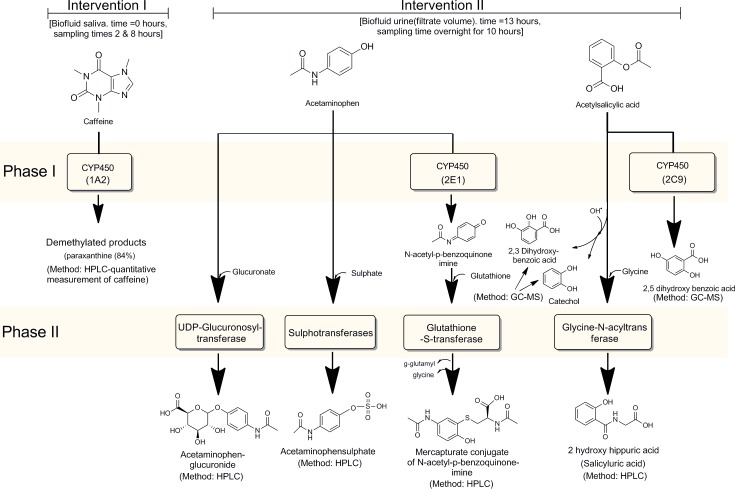
Measurement design for the interventions to assess the biotransformation profiles for all fatigue patients.Caffeine clearance (Intervention 1) progresses through CYP450-1A2, comprises only a phase 1 process and is measured as the residual substrate in saliva, expressed as a percentage of caffeine recovery. The acetaminophen challenge involves three phase II conjugation reactions, evaluated through the products formed following biotransformation: (1) conjugation of glucuronic acid to the hydroxyl group of acetaminophen; (2) sulphation of the phenolic hydroxyl group of acetaminophen; and (3) glutathione conjugation of N-acetyl-p-benzoquinone imine, a phase 1 activated form of acetaminophen. In the simultaneous acetylsalicylic acid challenge, glycination of the functional carboxylic group is catalysed by glycine-N-acyl transferase (GLYAT). All the substances mentioned are measured in urine samples, analysed by HPLC, as indicated. The acetaminophen and salicylate ingestion detoxification are measured through the glucuronide, sulphate and mercapturate conjugates as well as for salicyluric acid, expressed as percentage recovery. Three derivatives of salicylate may likewise be observed in this challenge (2,3-DHBA, 2,5-DHBA and catechol) and are measured by a GC-MS method. Abbreviations: CYP450-1A2, -2E1 and -2CP: mixed function CYP450 oxidase system with isozymes as indicated; GLYAT: glycine-N-acetyltransferase; HPLC: high-pressure liquid chromatography; GC-MS: gas chromatography–mass spectrometry; GSH: glutathione; 2,3-DHBA: 2,3-dihydroxy benzoic acid: 2,5-DHBA: 2,5-dihydroxybenzoic acid.